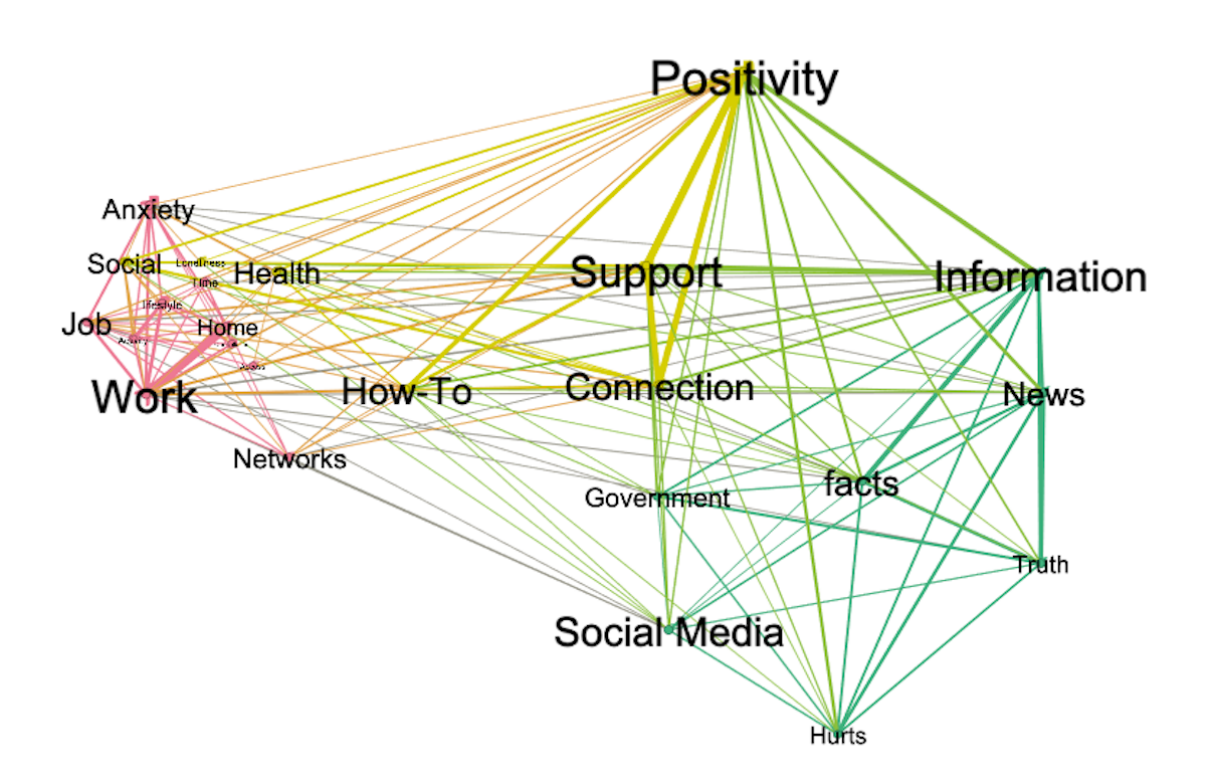
Figure 7. Results of qualitative network analysis. Colors represent network communities. The size of the letter is proportionate to eigenvector centrality (a measure of the hubness of each node). The thickness of edges reflects the weight of each